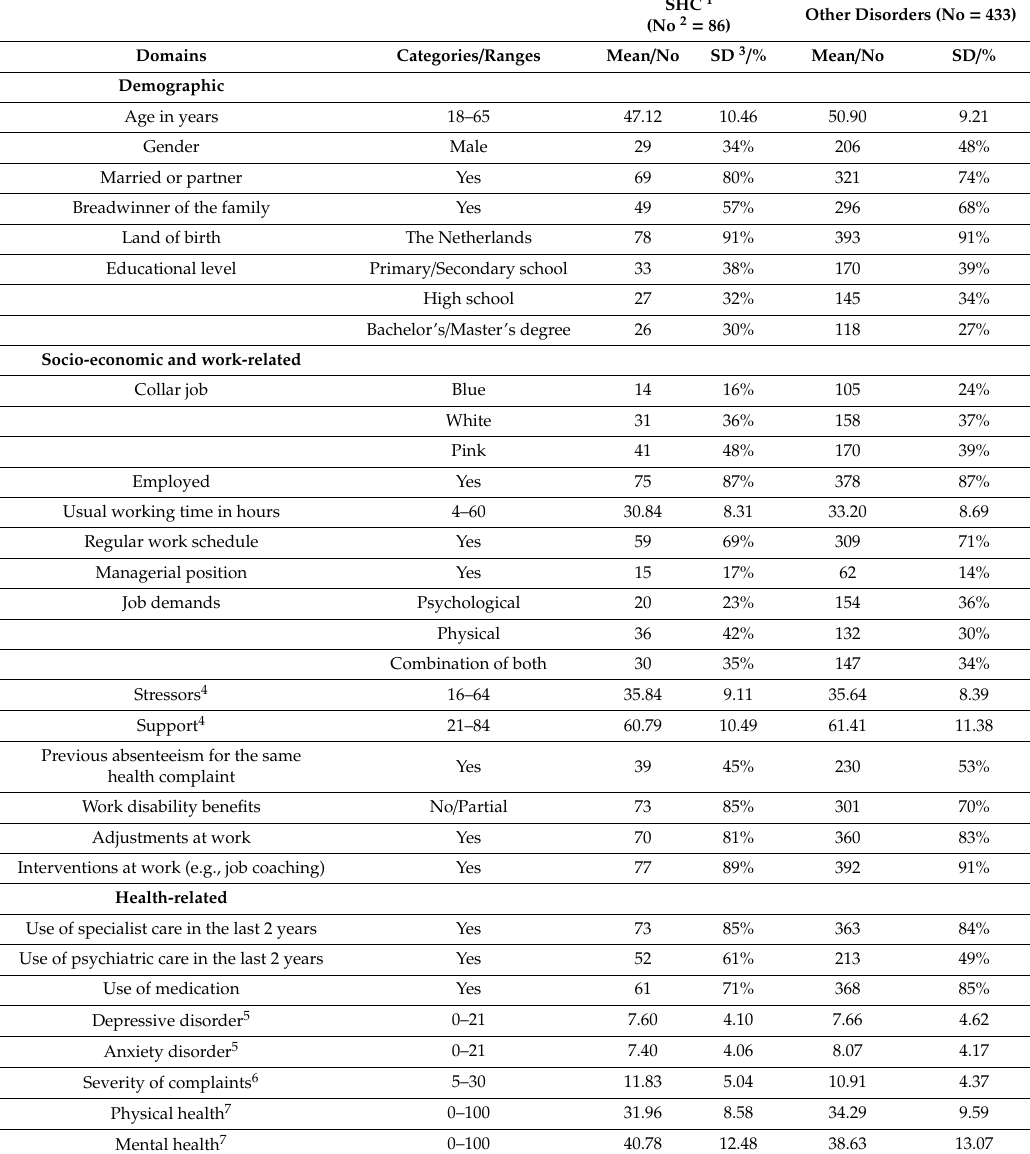
Table 1. Baseline characteristics of the study